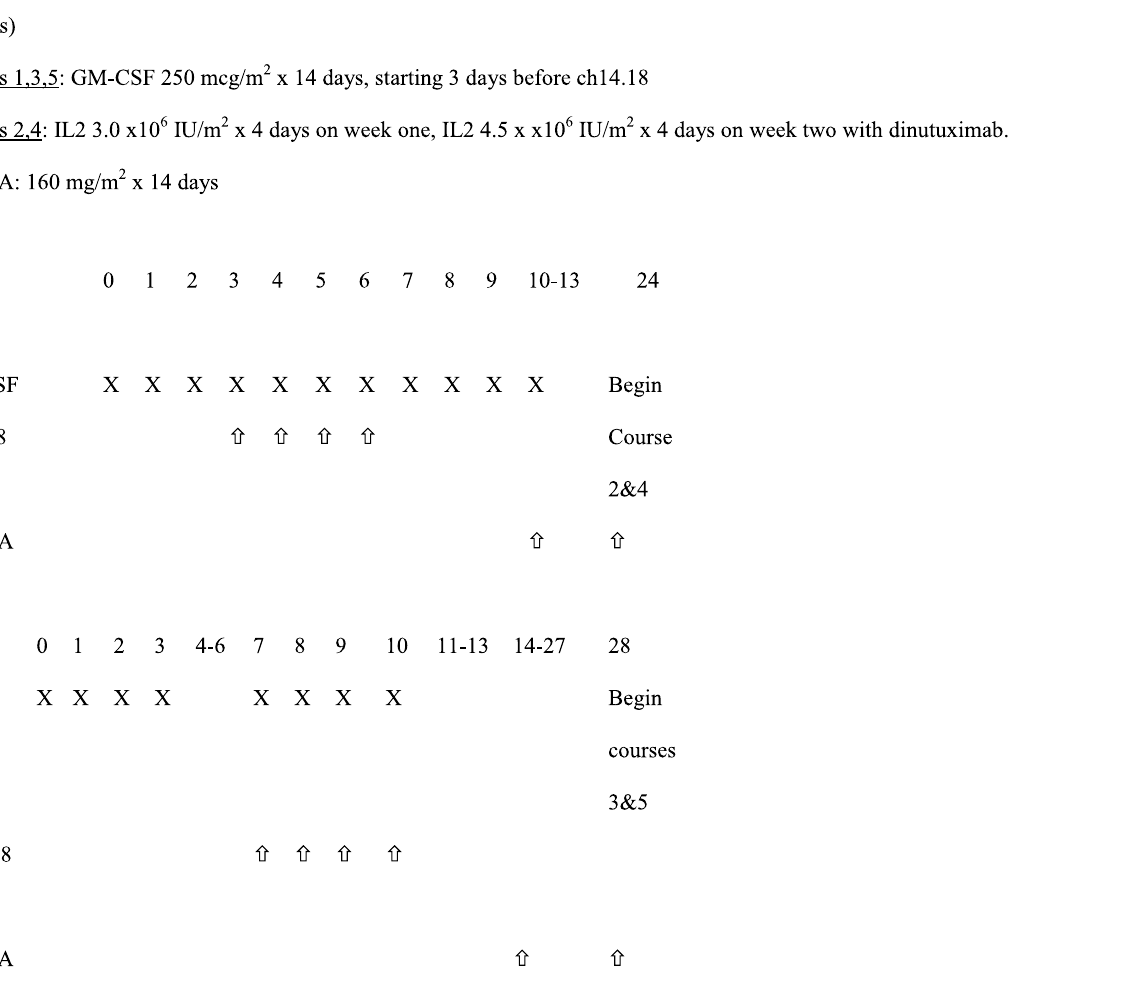
FiGUrE 1 | Immunotherapy treatment schema. (a) Schedule of overall dinutuximab, GM-CSF, IL2, and 13cisRA. (B) Treatment schema for courses 1, 3, and 5 with GM-CSF (28 days per course). (C) Treatment schema for courses 2 and 4 with